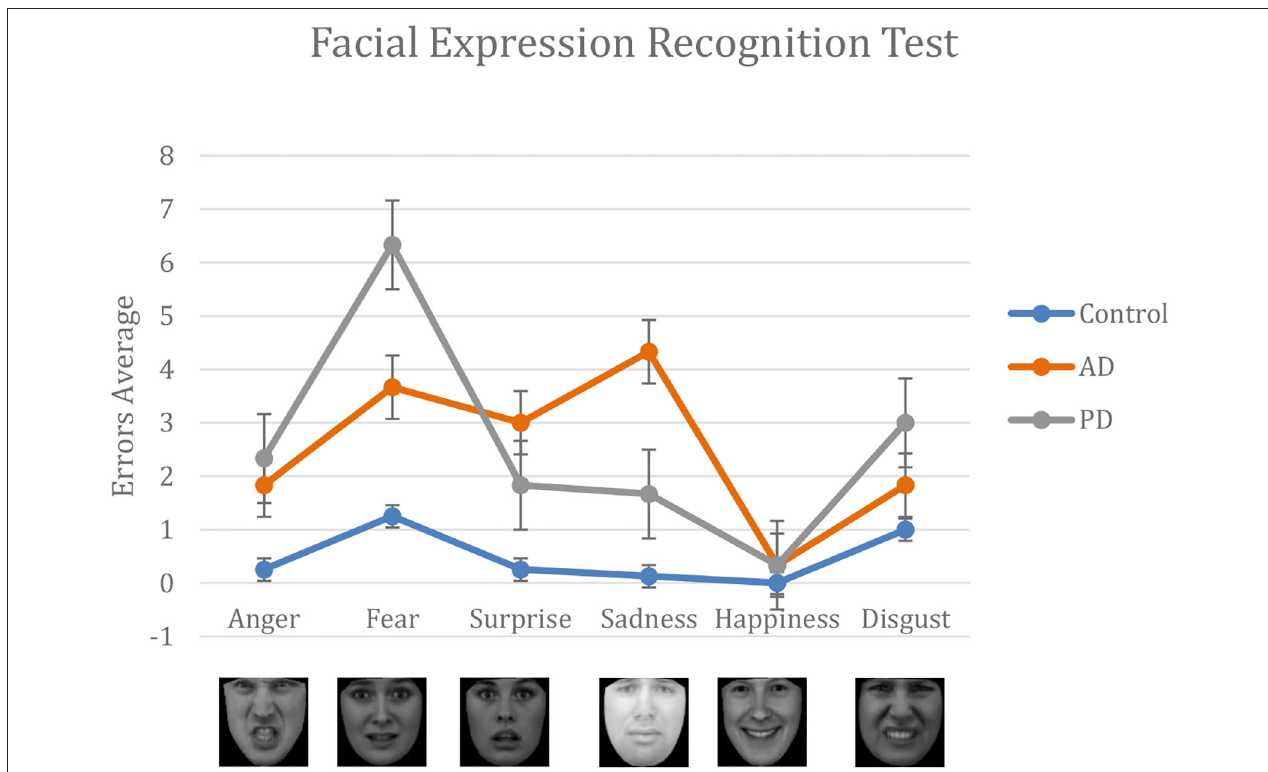
FIGURE 3 | Results from the FER test. For each emotion, we compare the number of errors made by AD, PD, and the control group. Performance of AD and PD are systematically worse than the control group. Happiness is the easiest emotion recognized by all